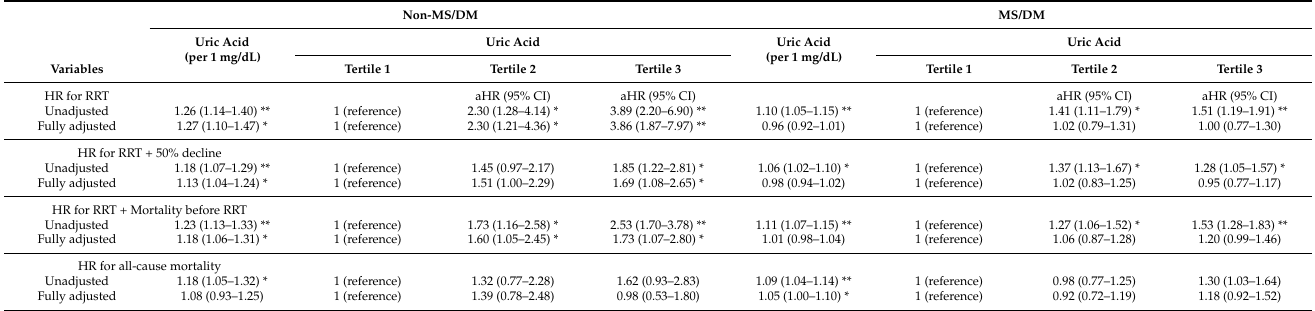
Table 4. HR of UA for clinical outcomes divided by MS/DM and UA.